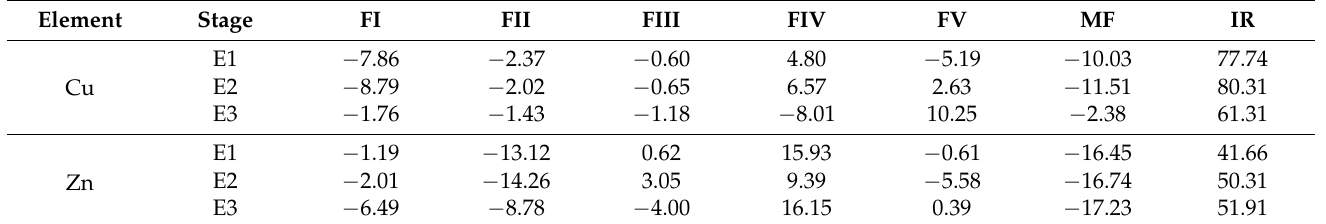
Table 5. Increments of Cu and Zn fractions during composting (end vs. start. %) for composts with different initial C/N and inactivation rate (IR) values.